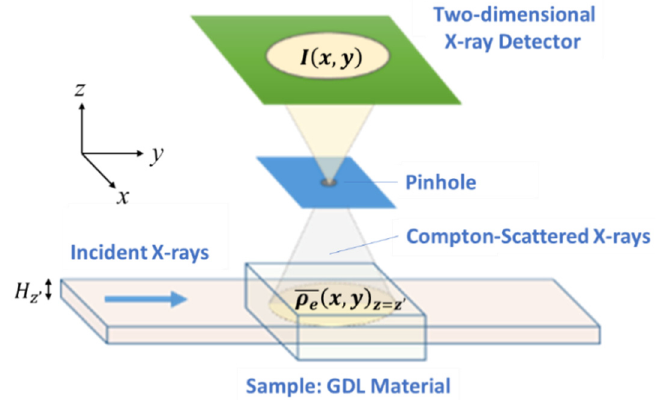
Figure 1. Experimental setup for Compton scattering imaging.